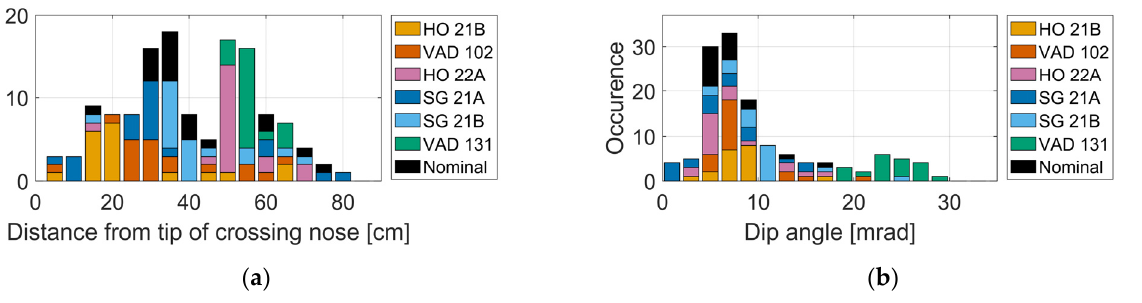
Figure 13. Crossing transition geometry indicators: ( a ) longitudinal position of wheel transition relative to the tip of the crossing nose, and ( b ) dip angle for the reversal in vertical wheel trajectory during the transition. The results correspond to 19 wheelsets passing through seven crossing panels.